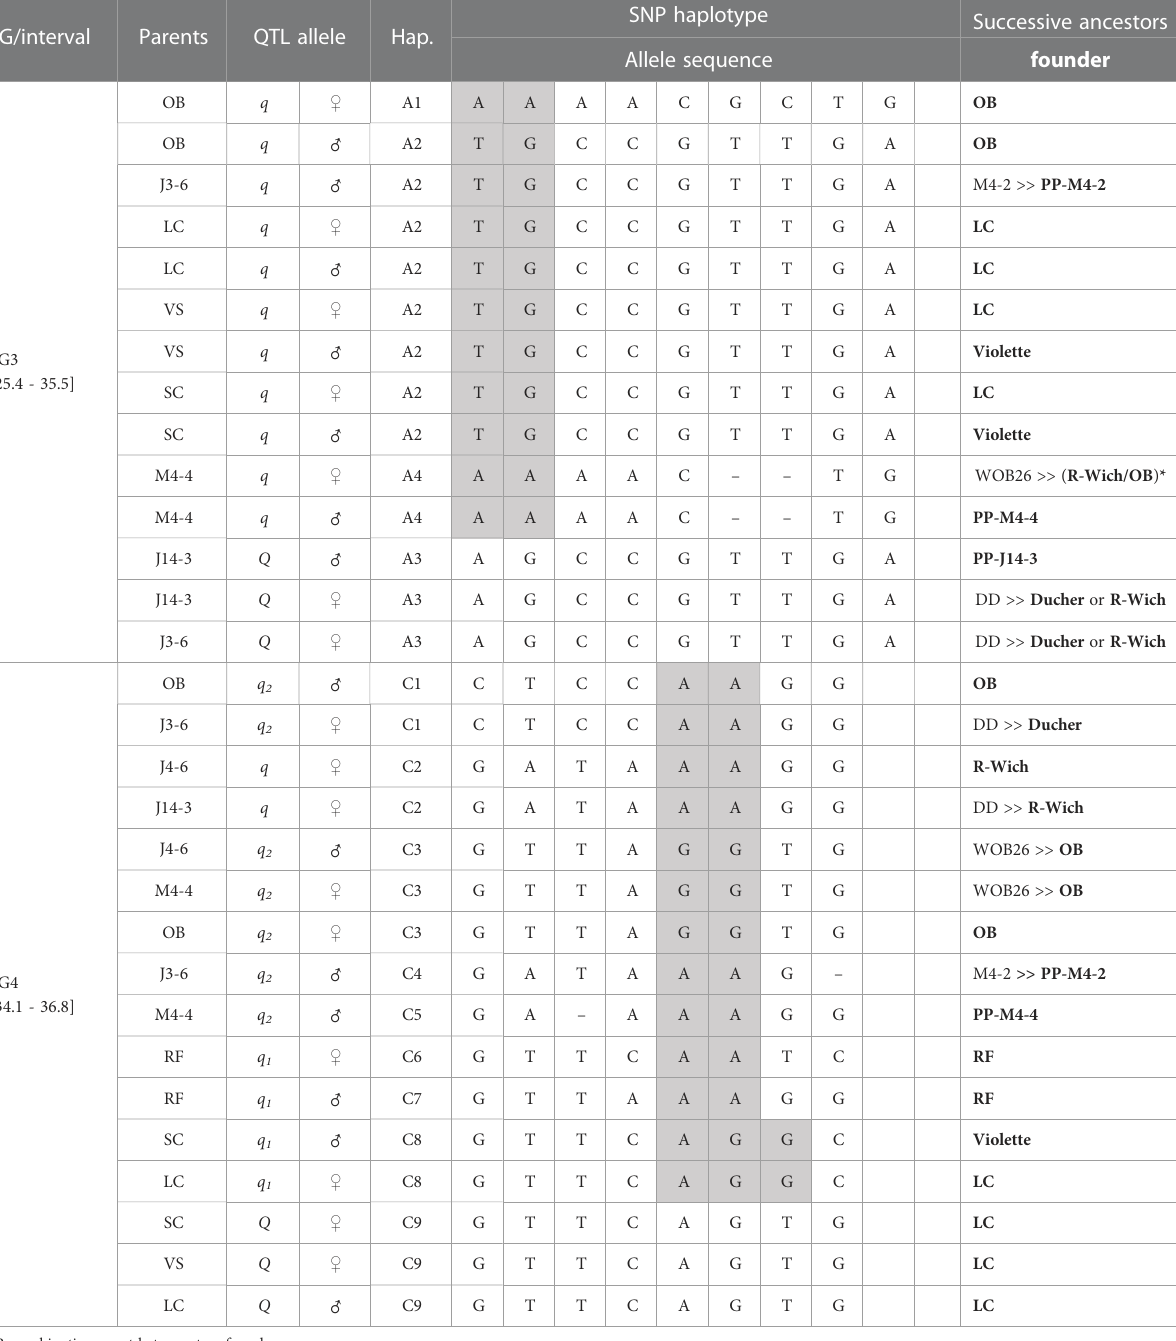
TABLE 3 QTL genotypes of q CLS.TX2WOB-LG3.2 and q CLS.TX2WOB-LG4.2 for studied breeding parents of the TX2WOB population, with SNP haplotype names, the haplotype ’ s SNP sequences, and original sources.